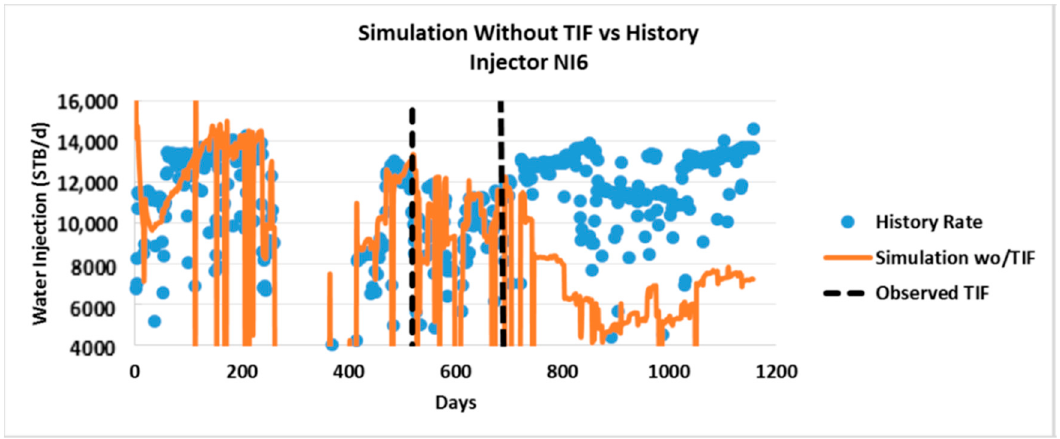
Figure 19. Simulation run versus the history for Injector NI6.